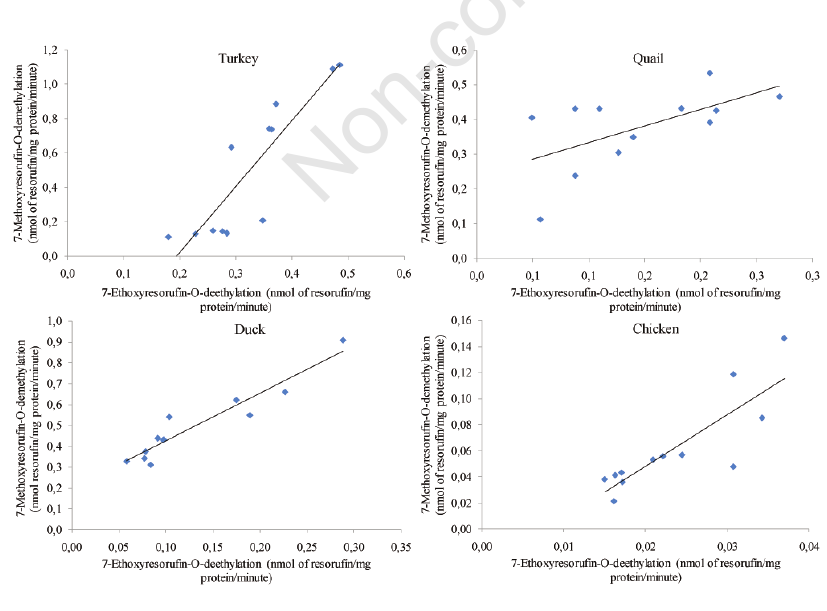
Figure 2. Linear regression of 7-Ethoxyresorufin- O -deethylase (EROD) vs 7-methoxyre- sorufin- O -deethylase (MROD) activities in liver microsomes (n=12) in four commercial poultry species. Correlation coefficients and level of significance are shown in the